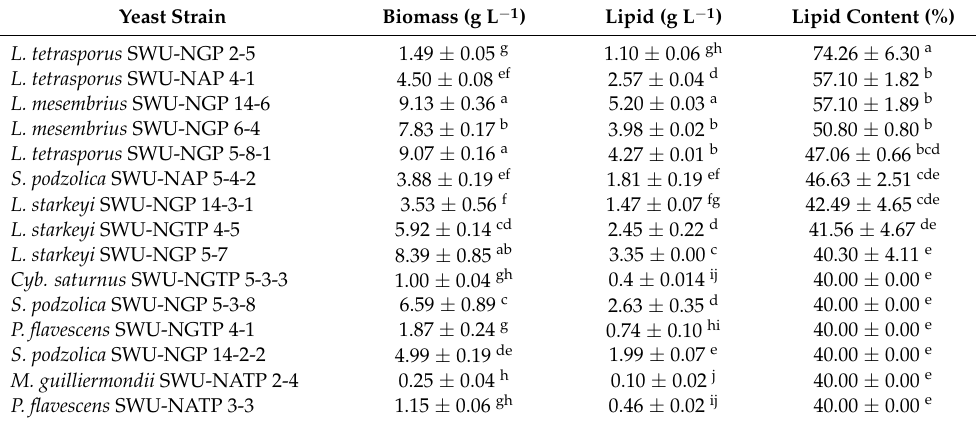
Table 2. Lipid accumulation of oleaginous yeast strains that accumulated lipids higher than 40% of dry biomass cultivated in 2G2M broth containing 20 g L − 1 glucose on a rotary shaker at 150 rpm and 30 ◦ C for 7 days.